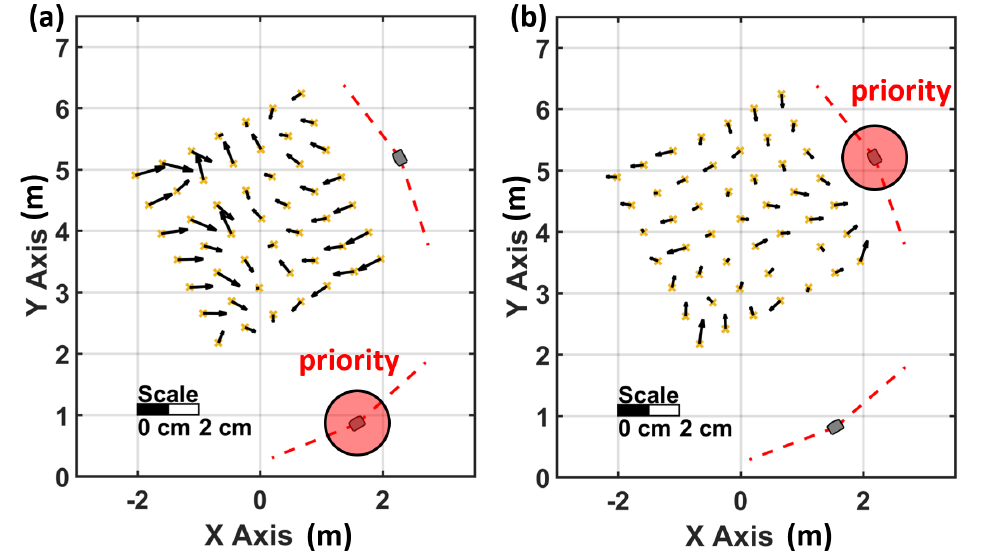
Figure 9. Horizontal deviations to total station measurements ( a ) before and ( b ) after bad tracking